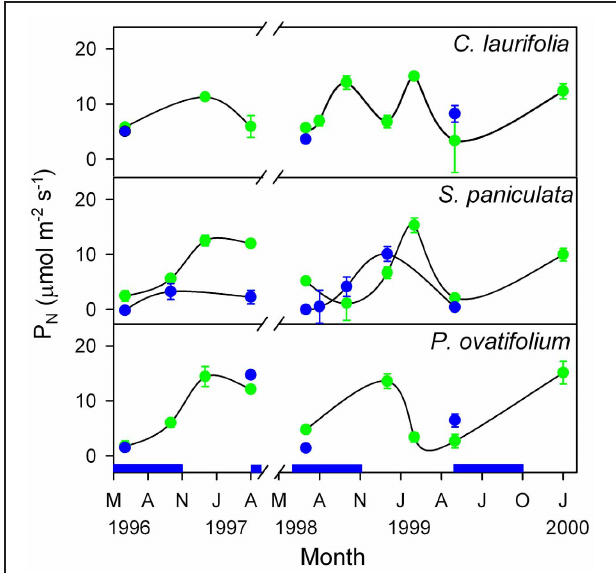
FIGURE 8 | Seasonal changes in photosynthetic rate of emerged and submerged leaves of the species indicated. Green circles, emerged leaves; blue circles, submerged leaves. The blue indicates the duration of the flood period. Modified from Herrera et al.